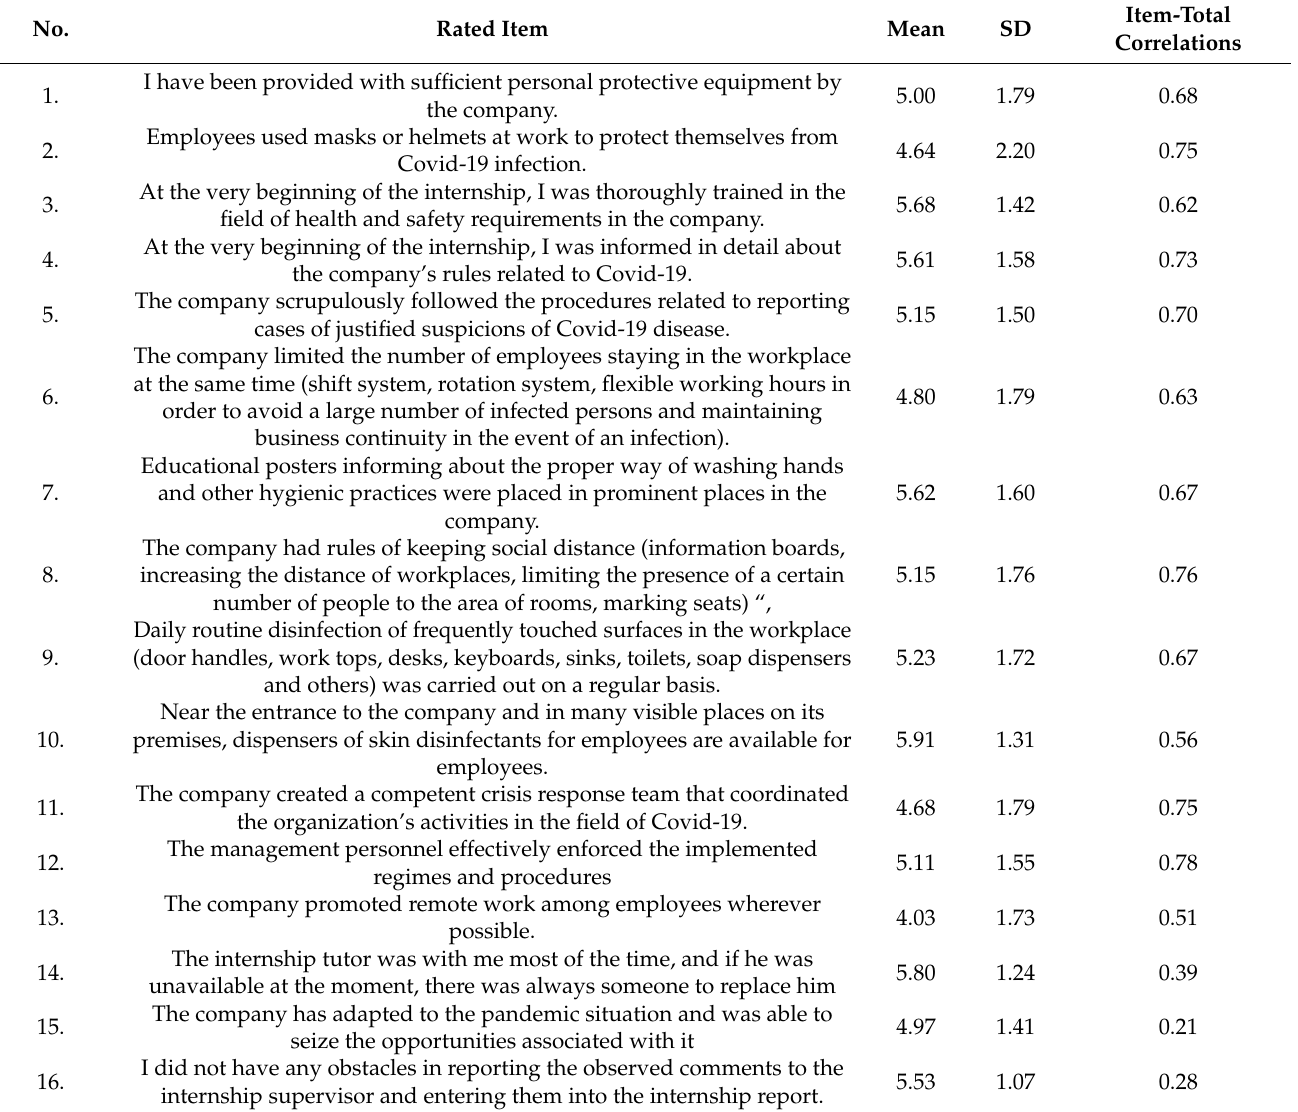
Table 5. Results of the internal consistency analysis.